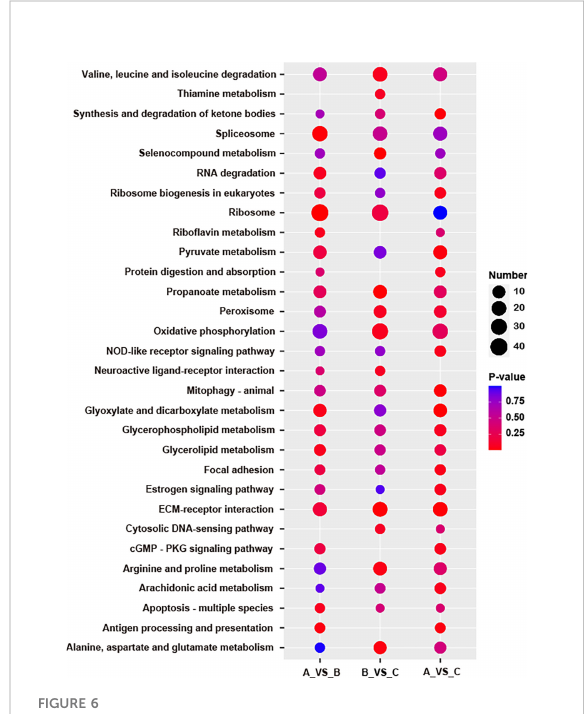
FIGURE 6 Pathways enriched by three DEPs